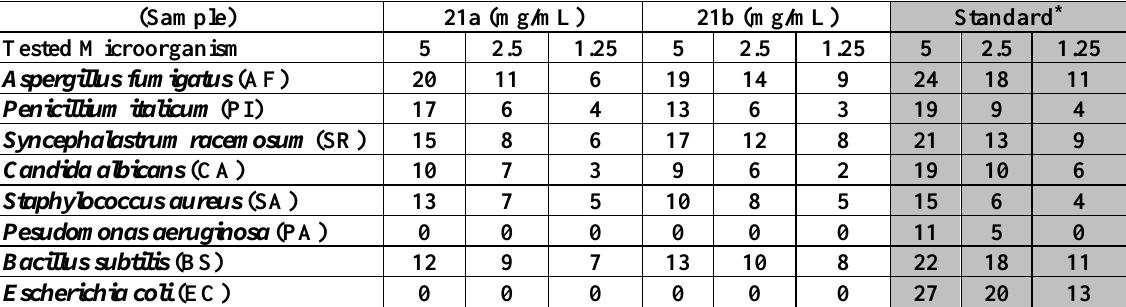
Table 3. Antimicrobial activity of products 21a and